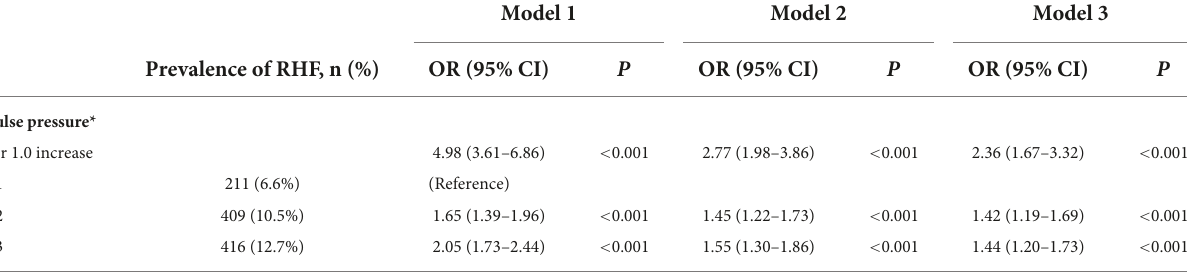
TABLE 3 Risk of RHF according to pulse